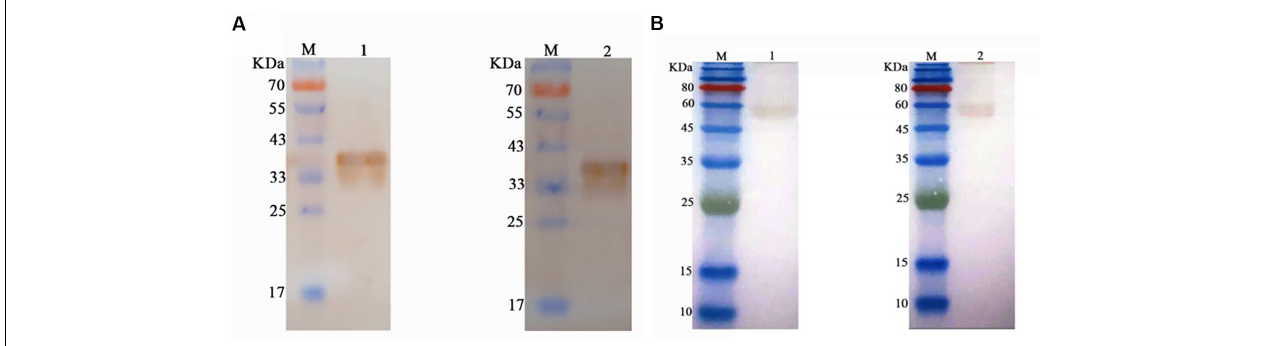
FIGURE 4 | Western blotting assay of B6 mAb and D17 mAb. (A) Western blotting assay of the purified PCV3 Cap protein, suggesting the specific band at 35 kDa. M, Protein Marker; Lane 1, Western blotting assay of the purified PCV3 Cap samples using B6 mAb; Lane 2, Western blotting assay of the purified PCV3 Cap samples using D17 mAb (B) Western blotting assay of the rescued PCV3, and the size of the bands on the PVDF membrane were approximately 60 kDa. M, Protein Marker; Lane 1, Western blotting assay of the rescued PCV3 using B6 mAb; Lane 2, Western blotting assay of the rescued PCV3 using D17